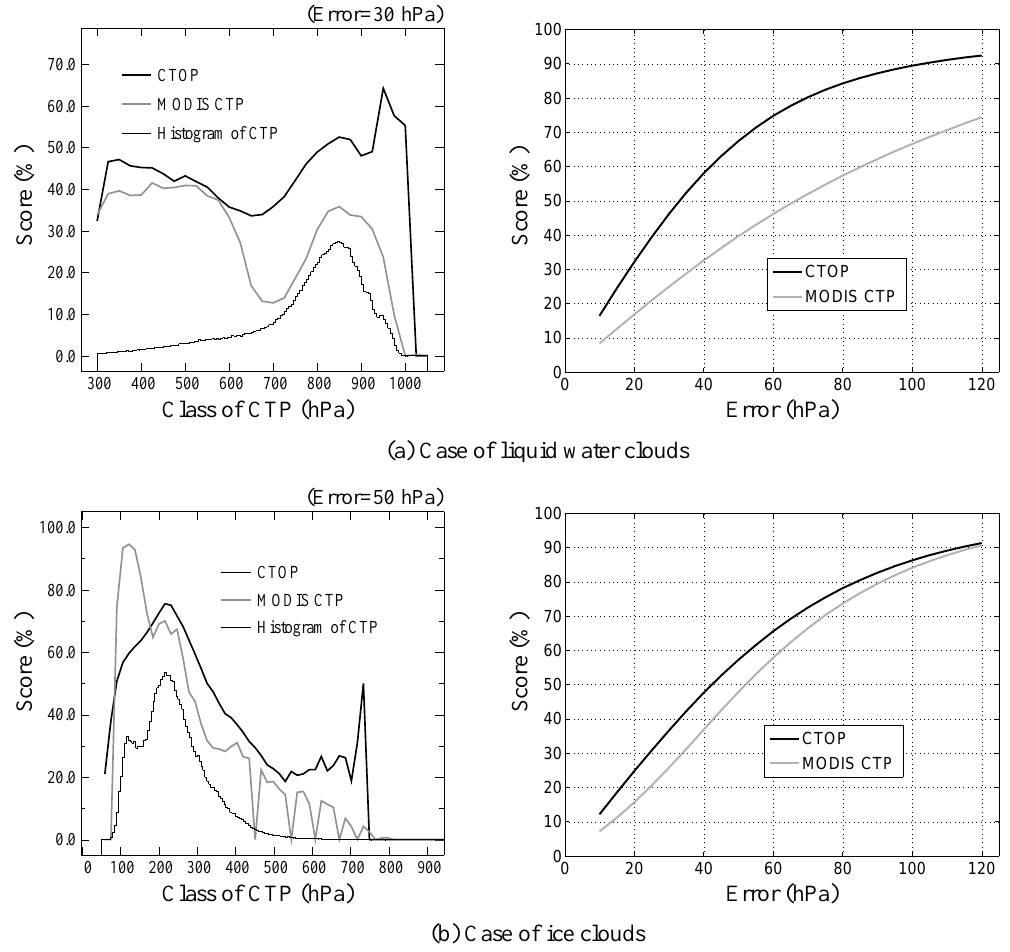
Fig. 9. Scores obtained in 2008 by the cloud top pressure estimates CTOP and MODIS CTP for liquid water (case a ) and ice clouds (case b ) over ocean. Scores correspond to a confidence in the retrieval for a given error. In the left-hand panels, scores are given per class of CTP, and for an error of 30hPa (50hPa) for liquid (ice) clouds. In the right-hand panels, scores are global (all classes of CTP) and are given for different error values. Thick black lines are for CTOP; thick grey for MODIS CTP. Histograms of CTP are also plotted in left-hand panels (thin black lines, in arbitrary